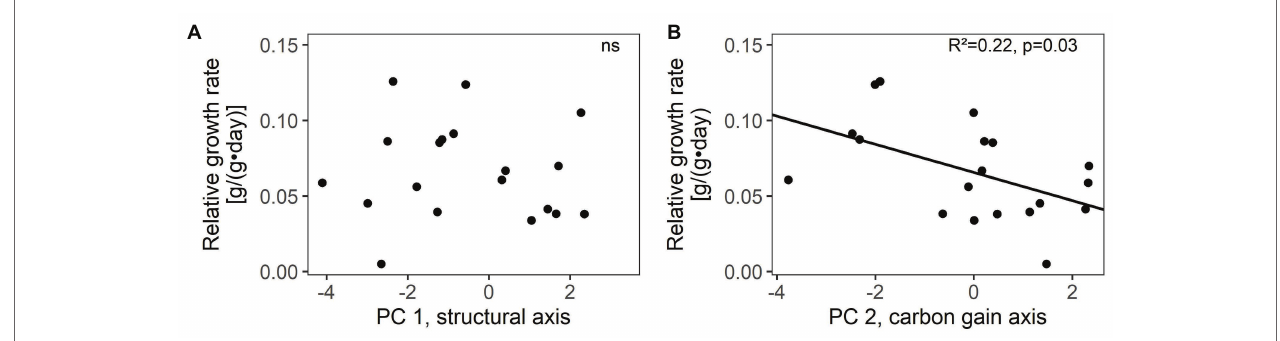
FIGURE 2 | Relations between relative growth rates and species’ scores along the two main trait axes of resource-use related traits: (A) structural trait axis (PC 1) and (B) carbon gain trait axis (PC 2) in 19 winter annual species. R 2 values and significance are given (ns not significant, for details see Supplementary Table S5 ). Species’ scores were based on the PCA in Figure 1 with 30 species.